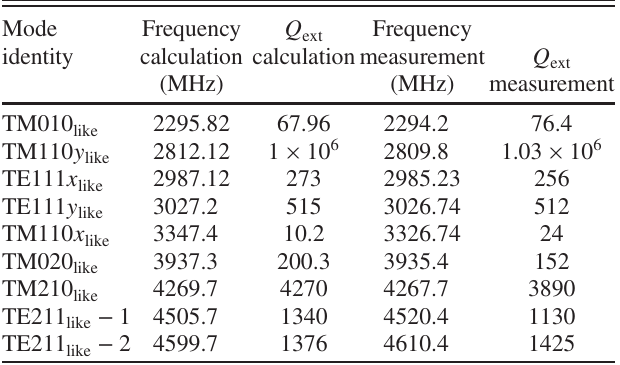
TABLE III. Mode frequencies and Q ments and